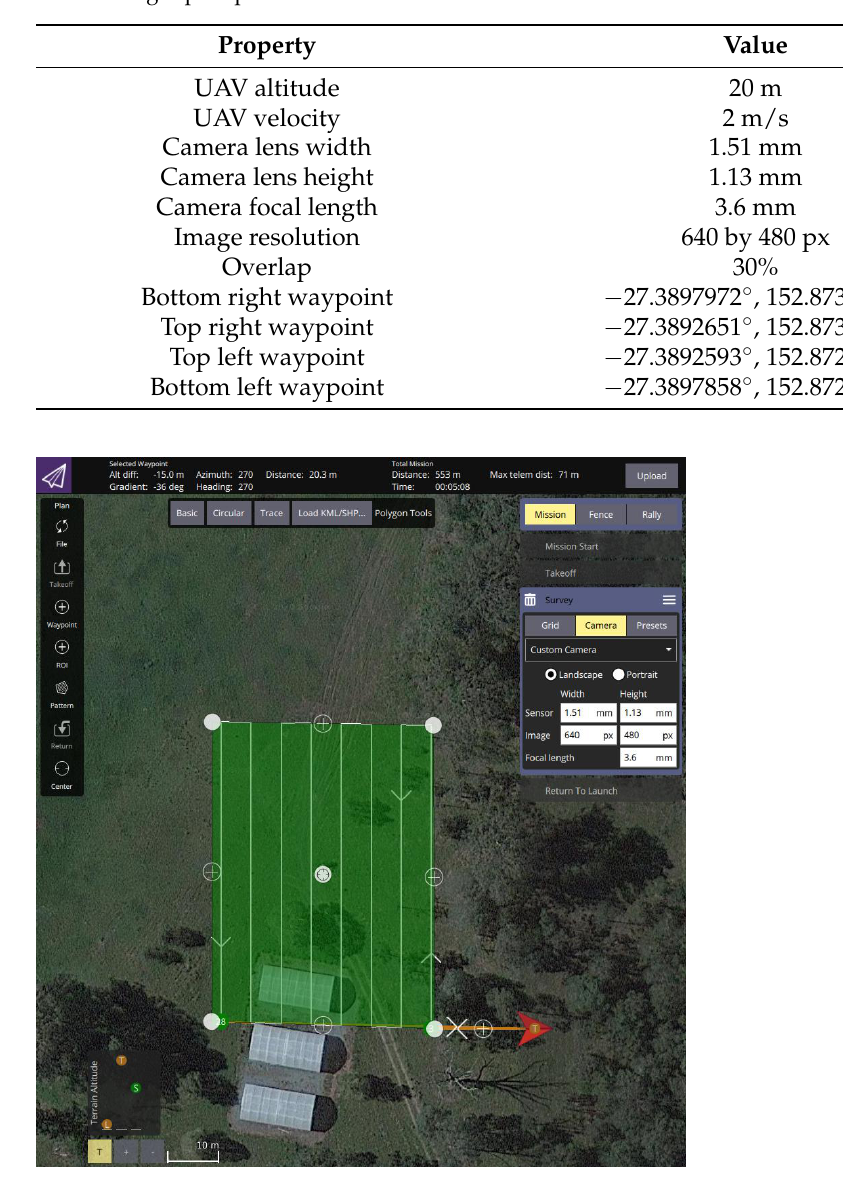
Table 3. Flight plan parameters for mission mode.